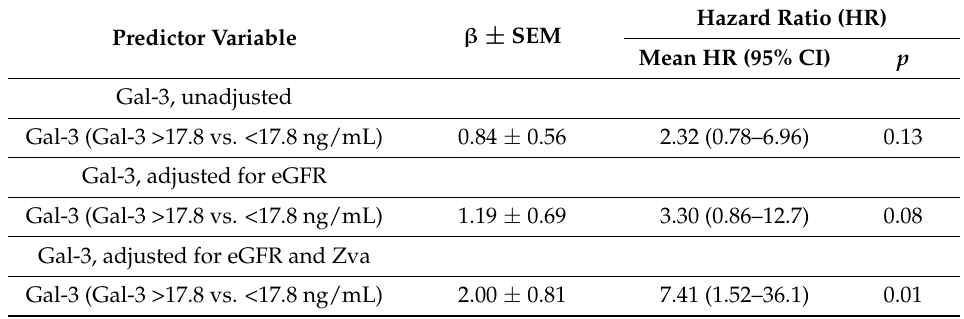
levels for AS patients undergoing balloon aortic